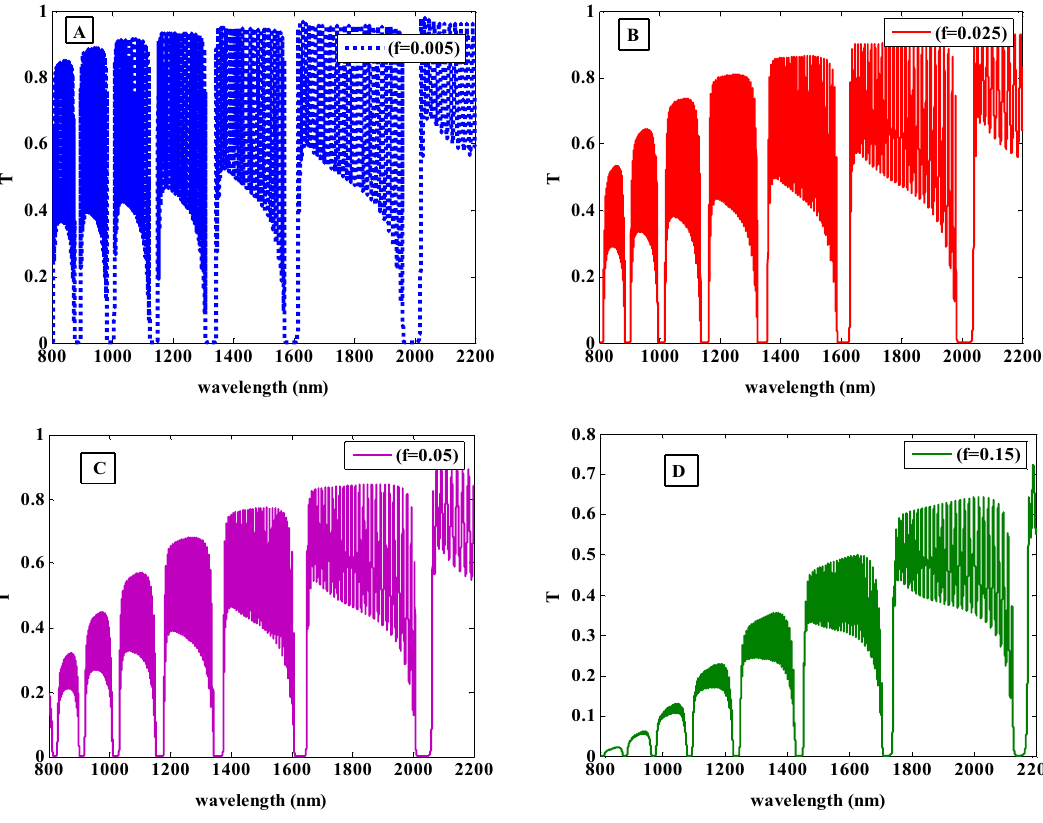
Figure 8. The transmittance spectra of the one-dimensional photonic crystal containing HMM at different filling fractions of Ag : Y 2 O 3